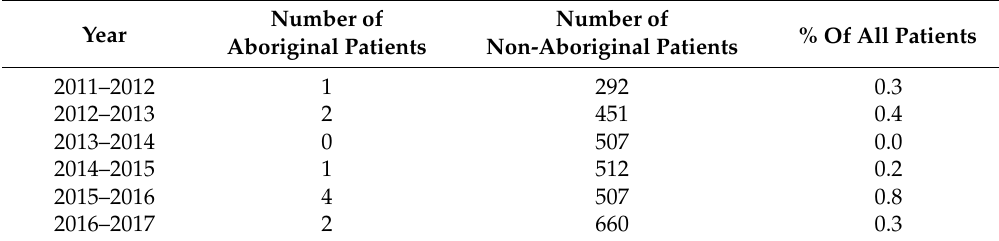
% Of All Patients